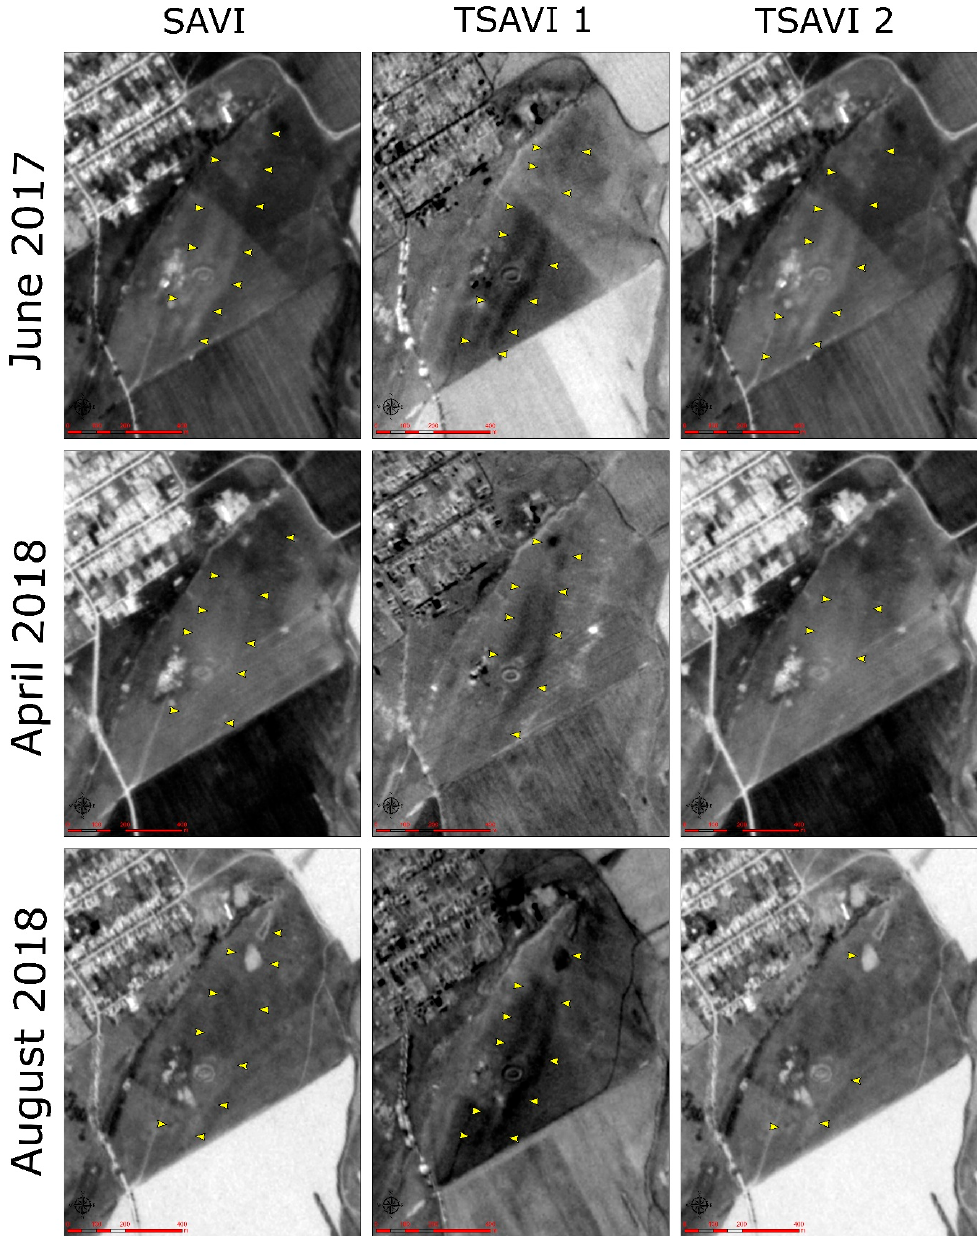
Figure 6. Results of SAVI, TSAVI 1 and TSAVI 2 algorithms. The yellow arrows indicate the features shown in each image.